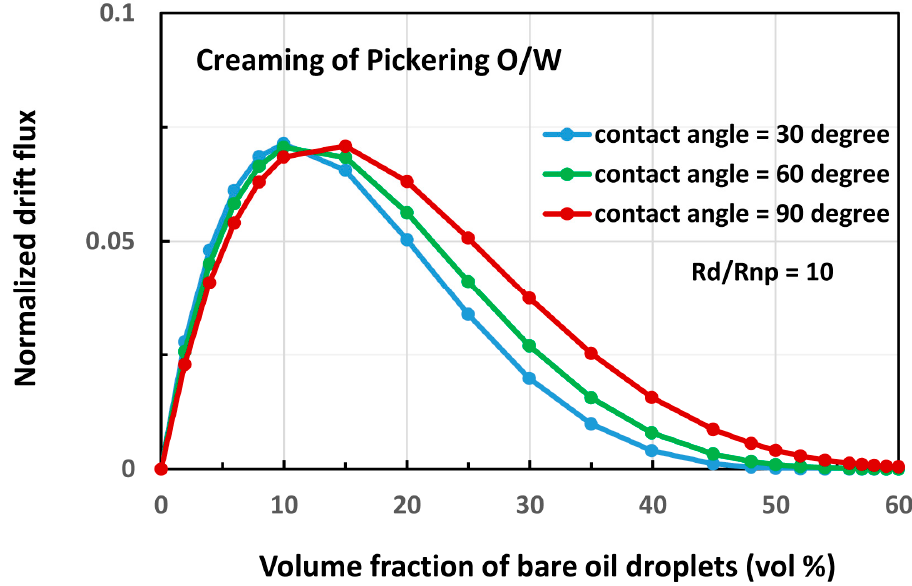
Figure 18. Effect of contact angle on normalized drift flux of Pickering O/W emulsions. Figure 18. E ff ect of contact angle on normalized drift flux of Pickering O / W emulsions. Fluids 2019 , 4 , x FOR PEER REVIEW